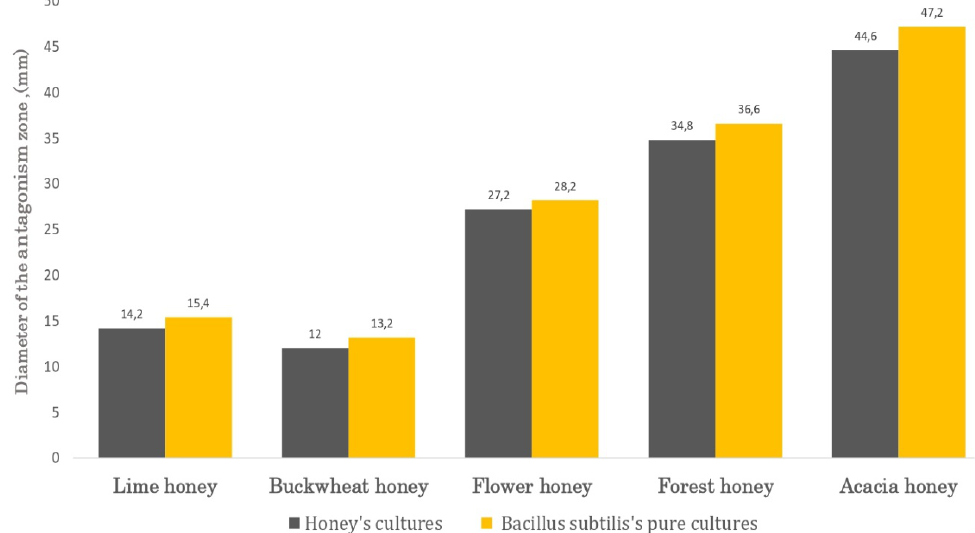
Fig. 2. Antagonistic effect of honey microflora and pure culture of Bacillus subtilis against the pure culture of enterobacteria of bees of Klebsiella pneumoniae species